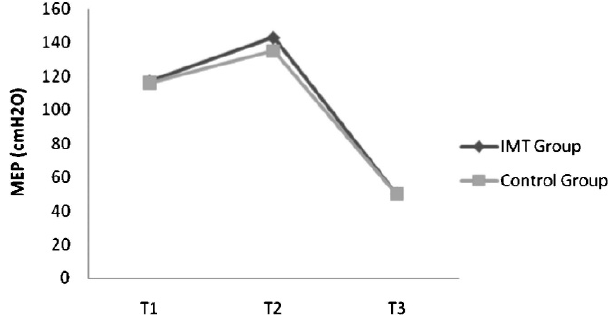
Figure 2 - MIP evaluations of T1, T2, and T3 in IMT (n=15) and control (n=17) groups. *Difference between IMT and Control groups (T2), p , 0.05. (values expressed as mean)’’.